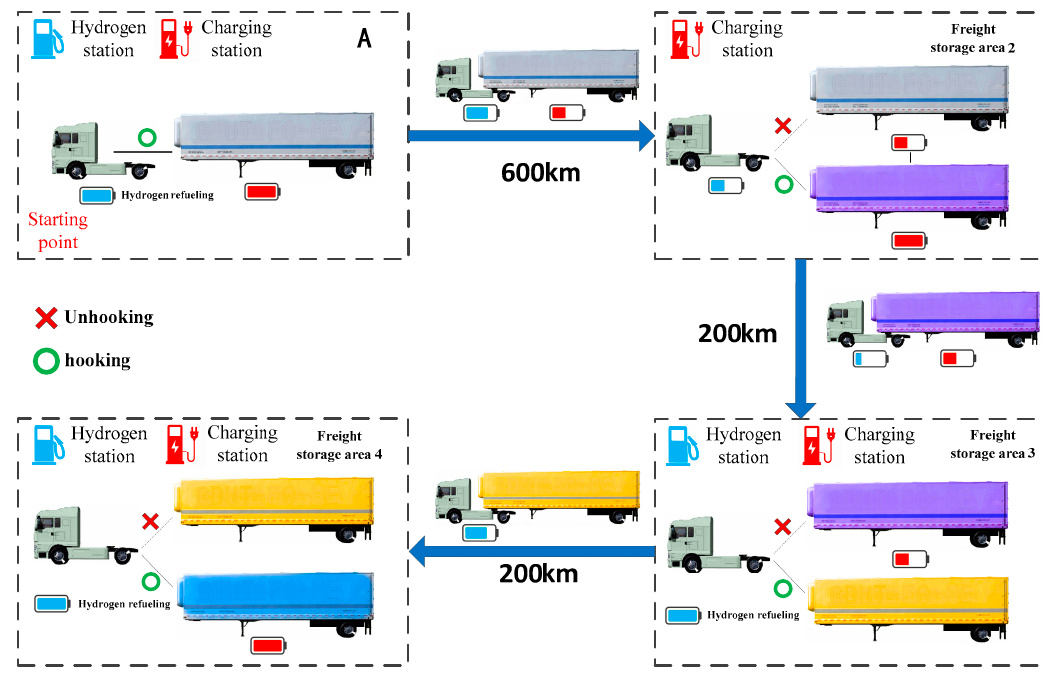
Figure 3. Drop-and-pull transport using fuel-cell electric articulated vehicles.